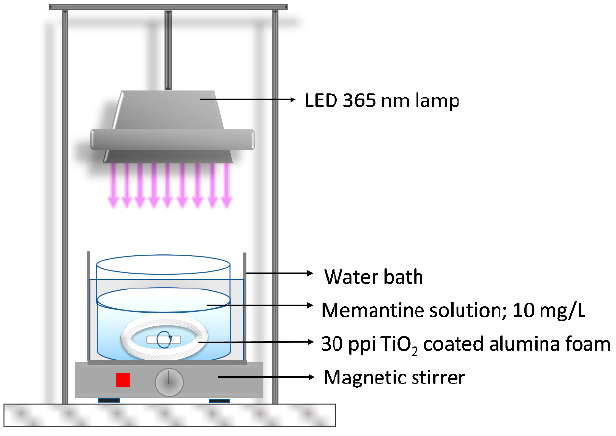
Figure 2. Scheme of photoreactor system.